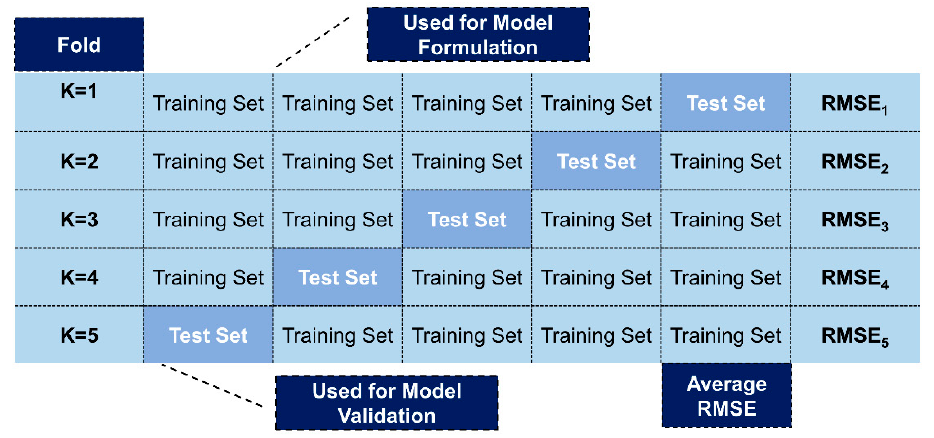
Figure 1. Flowchart representing K-fold model validation.